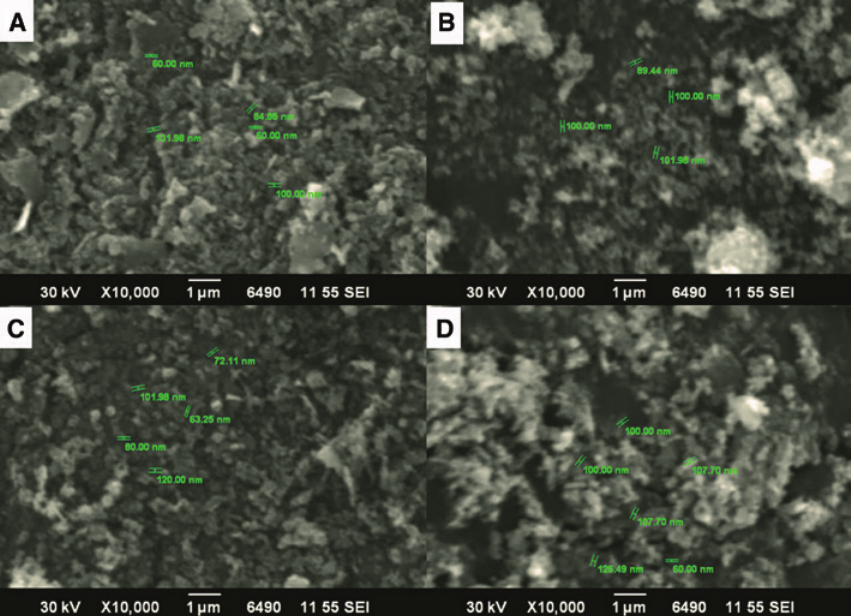
Figure 3: Scanning electron microscopy micrographs of foliar doped nanoparticles at (A) 30, (B) 50, (C) 70, and (D) 90 ml P. cerasifera leaf extract concentration.